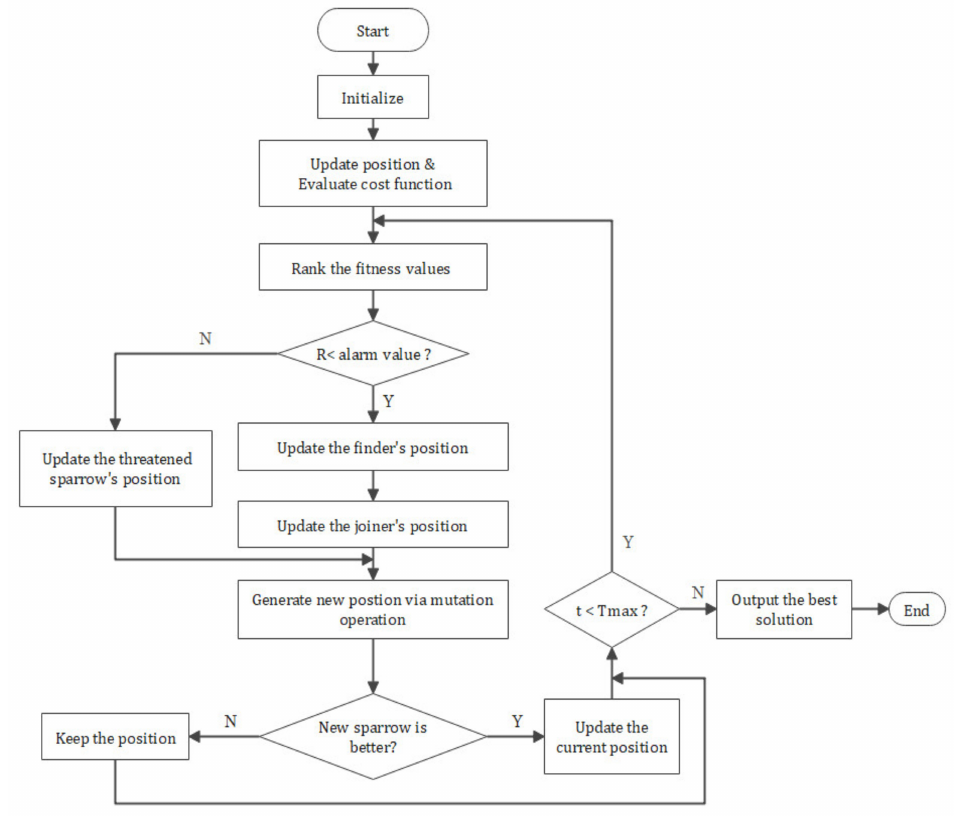
Figure 3. The flowchart of